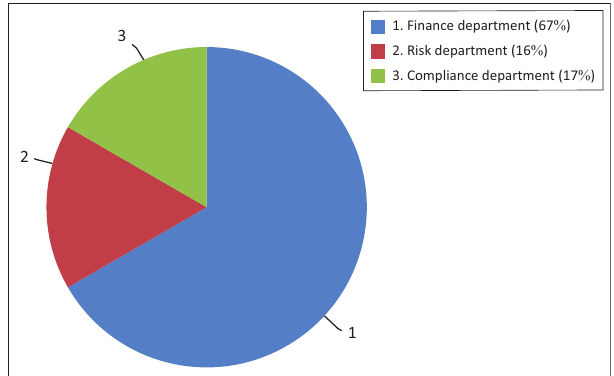
FIG URE 9: Responsibility for economic capital calculations.